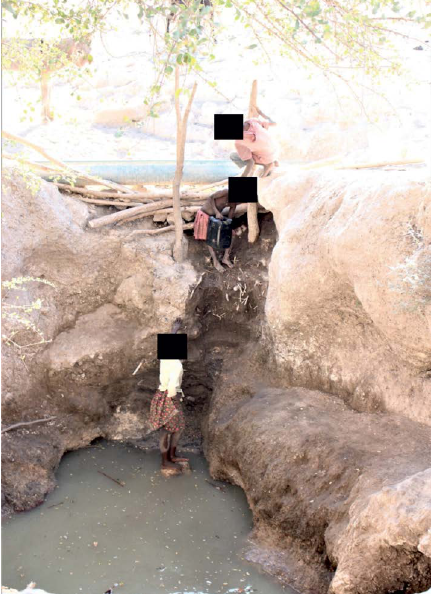
Fig. 2. A picture of type 2 shallow hand-dug wells found in Ohangwena and Omusati regions of the CEB in which animals cannot walk into the water.